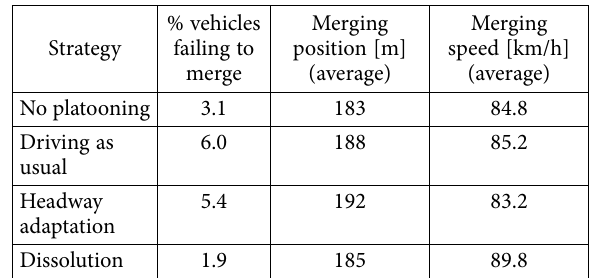
Table 3. Overview of the numerical outputs concerning